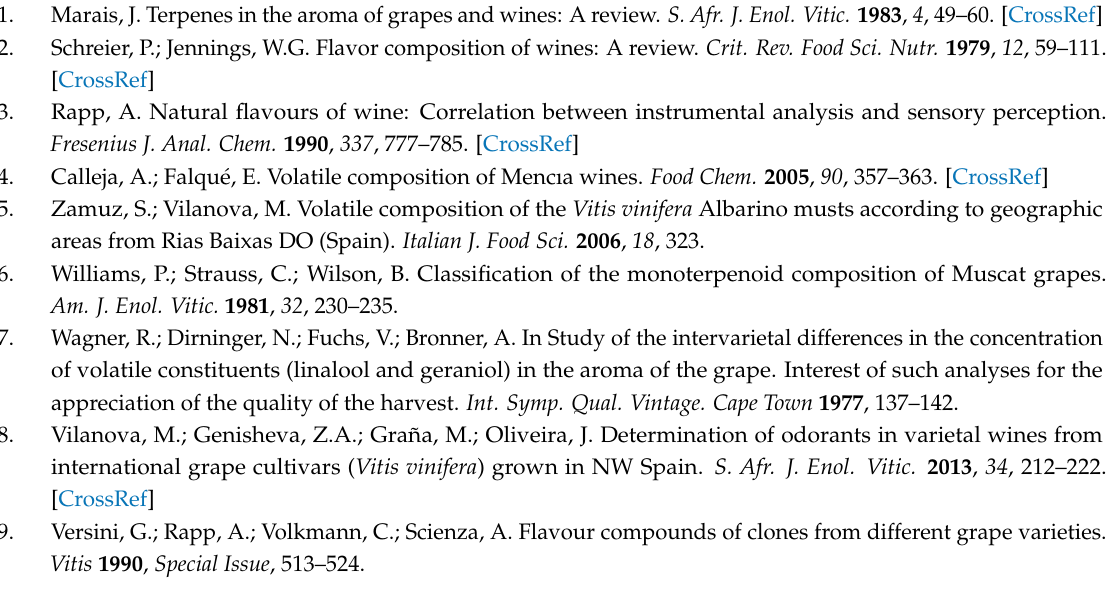
varietal and style effects, Table S4: Structure matrix of variable correlations for wine styles classification by discriminant, Figure S1: A-B, Chromatograph of the monoterpene isomers in one Torrontes varietal wine from MDGC-MS. A-30 min to 63 min (small spectrum with selected ions of S -( − )-limonene, (2 R , 4 R )-( − )- trans -rose oxide, and (2 R , 5 S )-( − )- cis -linalool oxide attached due to co-eluted with other compounds), B-63 min to 87 min, Figure S2: Monoterpene isomers vector loadings for varietal wines classification by discriminant analysis, Figure S3: X-Y scatterplots of enantiomer pair concentrations ( µ g/L) in all varietal wines with fitted lines and adjusted R 2